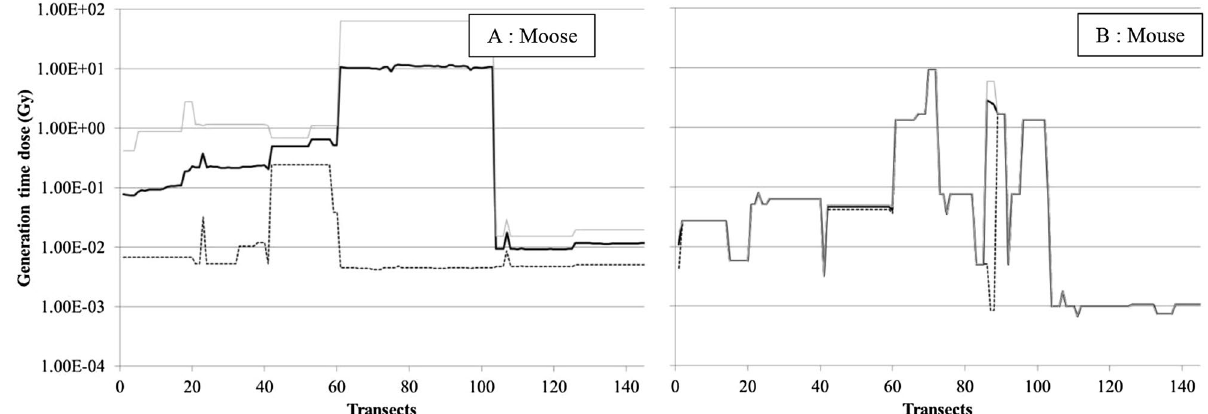
Figure 2. Spatial change of the total dose absorbed by moose and mice over their generation time (result by transect, calculated with minimal (dotted line), mean (black line) and maximal (grey line) activity concentrations of 137 Cs and 90 Sr in soil for the given transect).